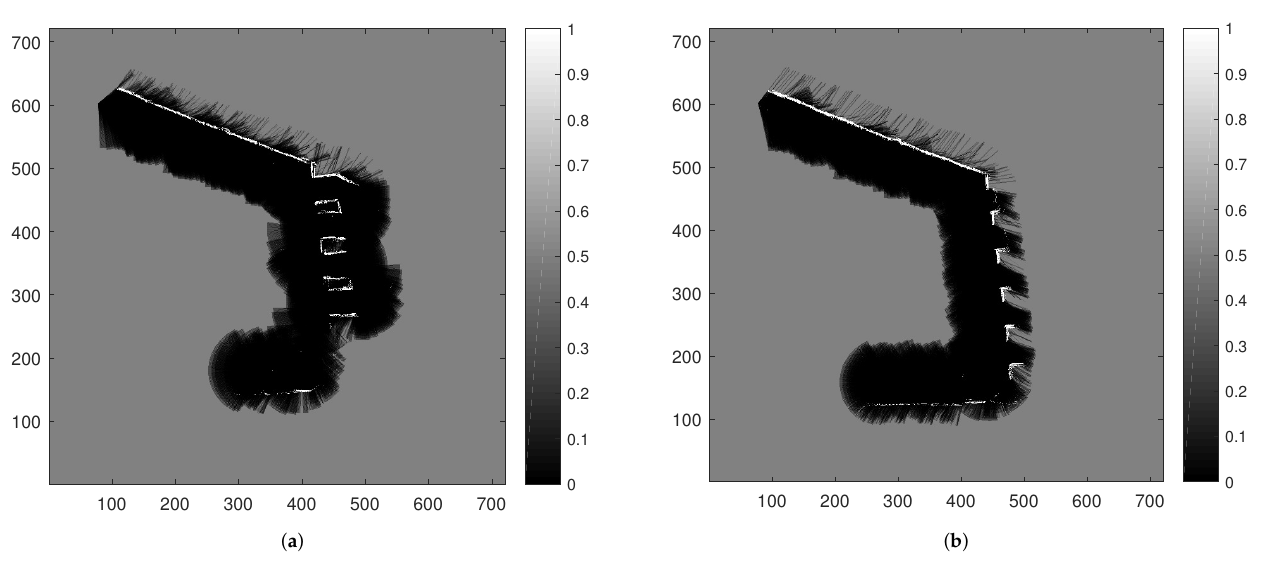
Figure 12. Probabilistic grid map of the SLAM navigation system. ( a ) Probabilistic grid map of the SLAM navigation system in Test 1. ( b ) Probabilistic grid map of the SLAM navigation system in Test